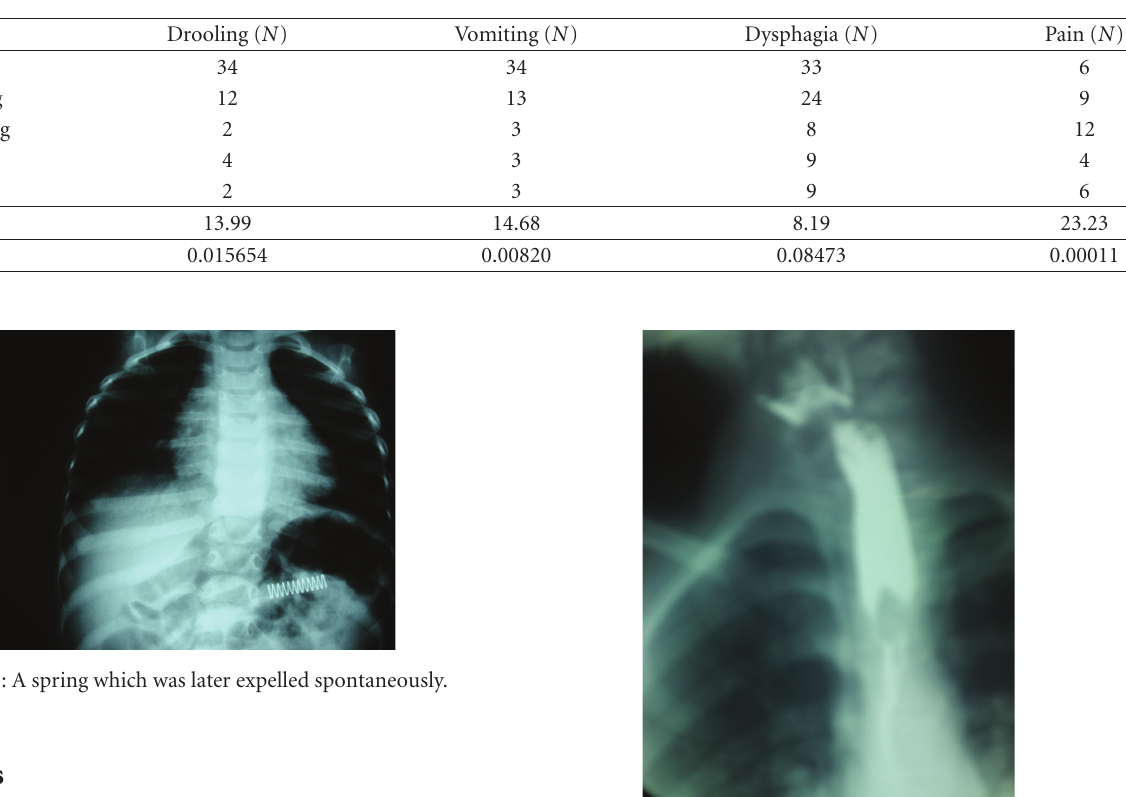
Table 2: Most frequent clinical symptoms of esophageal FB, depending on location.